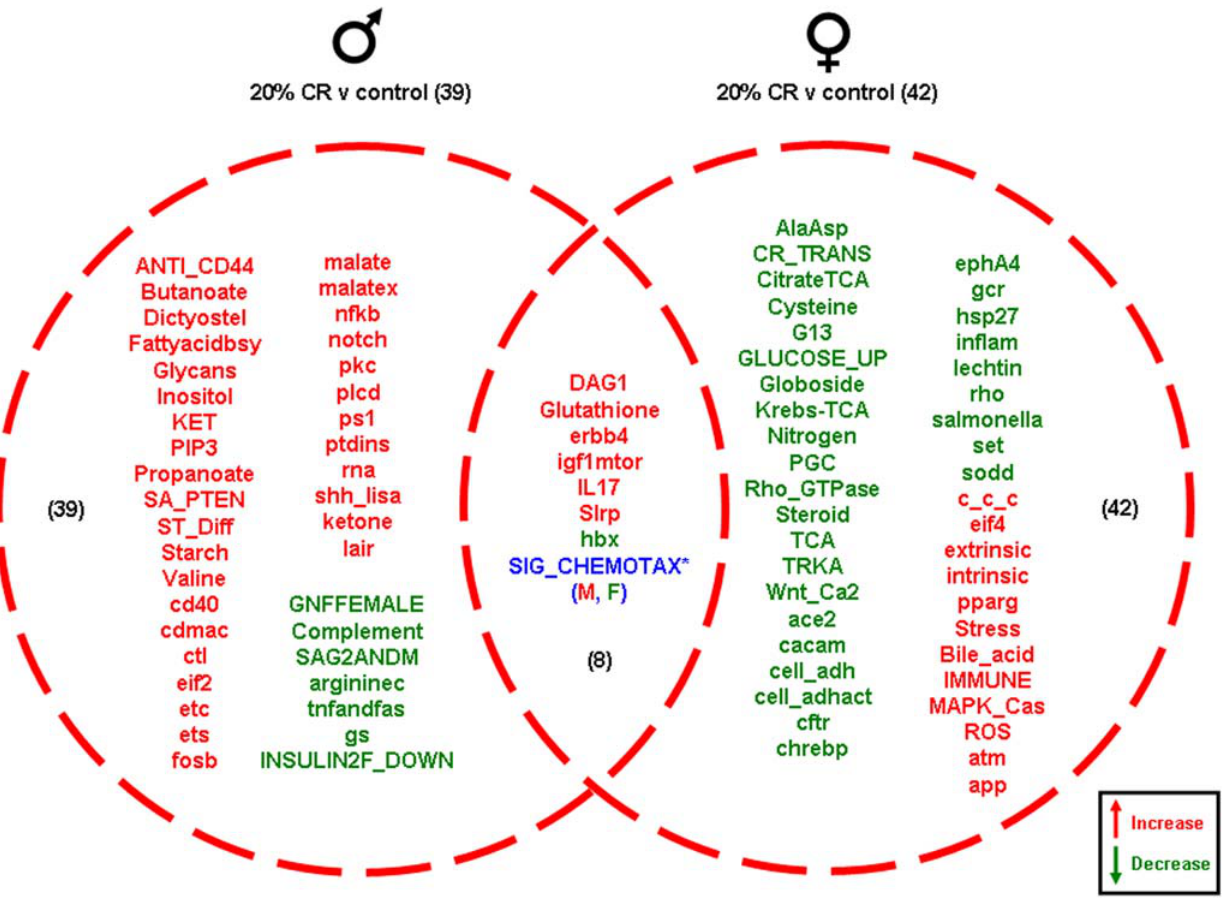
Figure 9. Pathway changes in the gonads of male and female rats maintained on the 20% CR diet compared to the gonads of male and female rats maintained on the control ( adlibitum ) diet. Significantly regulated, functional pathway clusters were generated from the respective male or female gene sets using PAGE gene set analysis. Pathways that were significantly up-regulated (red) or down-regulated (green) were clustered into a Venn diagram. Pathways in blue were common to both males and females but were differentially regulated, e.g. the SIG_CHEMOTAX pathway, was differentially altered in the 20% CR male (M) and female (F) gonads. This pathway was up-regulated in the males and down regulated in the females in comparison to ad libitum controls. Names of the significantly altered pathways can be found in Table S2.